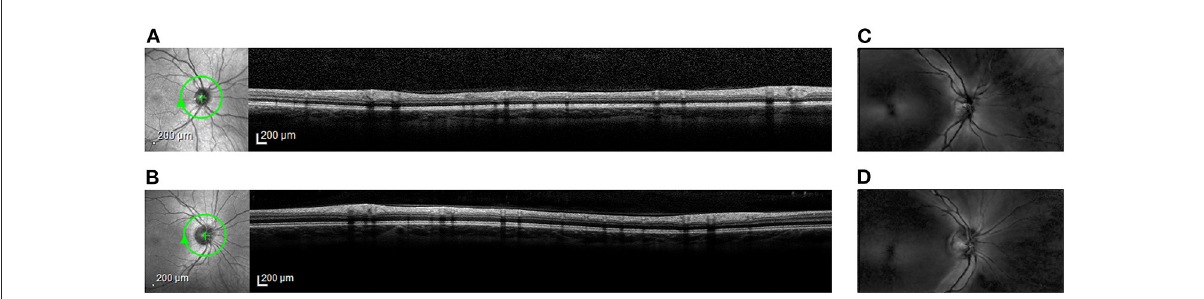
FIGURE1 Representative retinal images from spectral-domain optical coherence tomography (OCT) and from scanning laser polarimetry (SLP). En face scanning laser ophthalmoscope (SLO) images (left) and cross-sectional OCT images (right) from (A) Case Subject 110 and from (B) Control Subject 203. The green circle around the optic nerve head in the SLO image marks the location of the accompanying OCT image. En face SLP images from (C) Case Subject 110 and from (D) Control Subject 203. Bright regions in the SLP image indicate areas of high phase retardation.